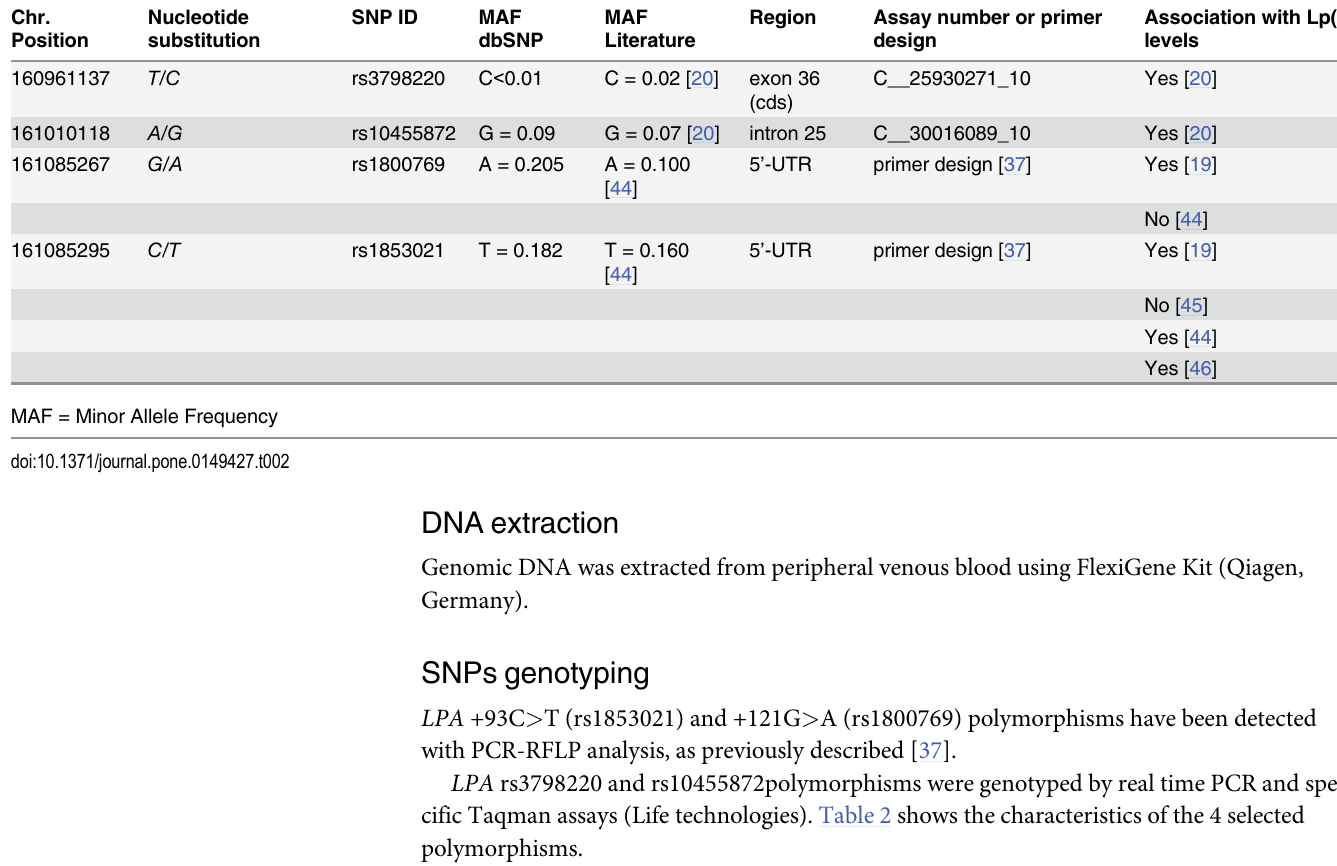
Table 2. Characteristics of the 4 selected LPA gene single nucleotide polymorphisms (SNPs). Chr.